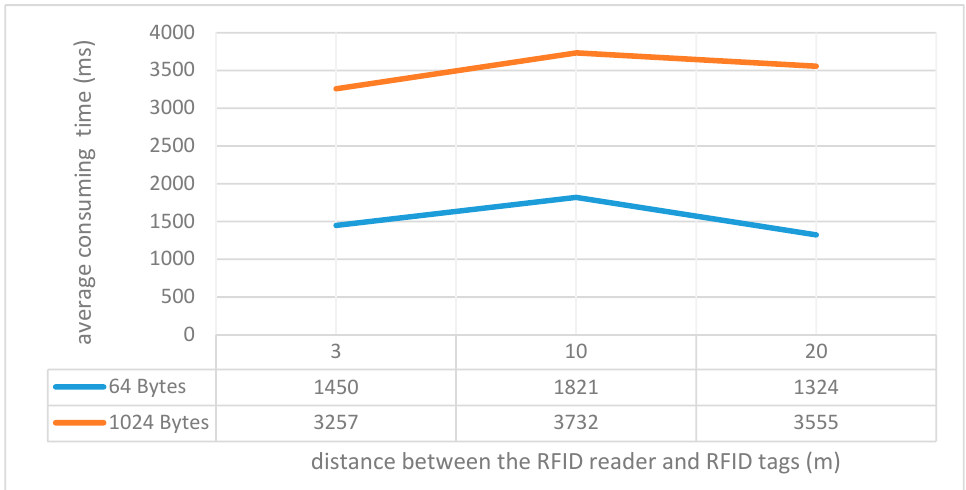
Figure 13. Average time consumed for reading different volumes of data (64 bytes and 1024 bytes in